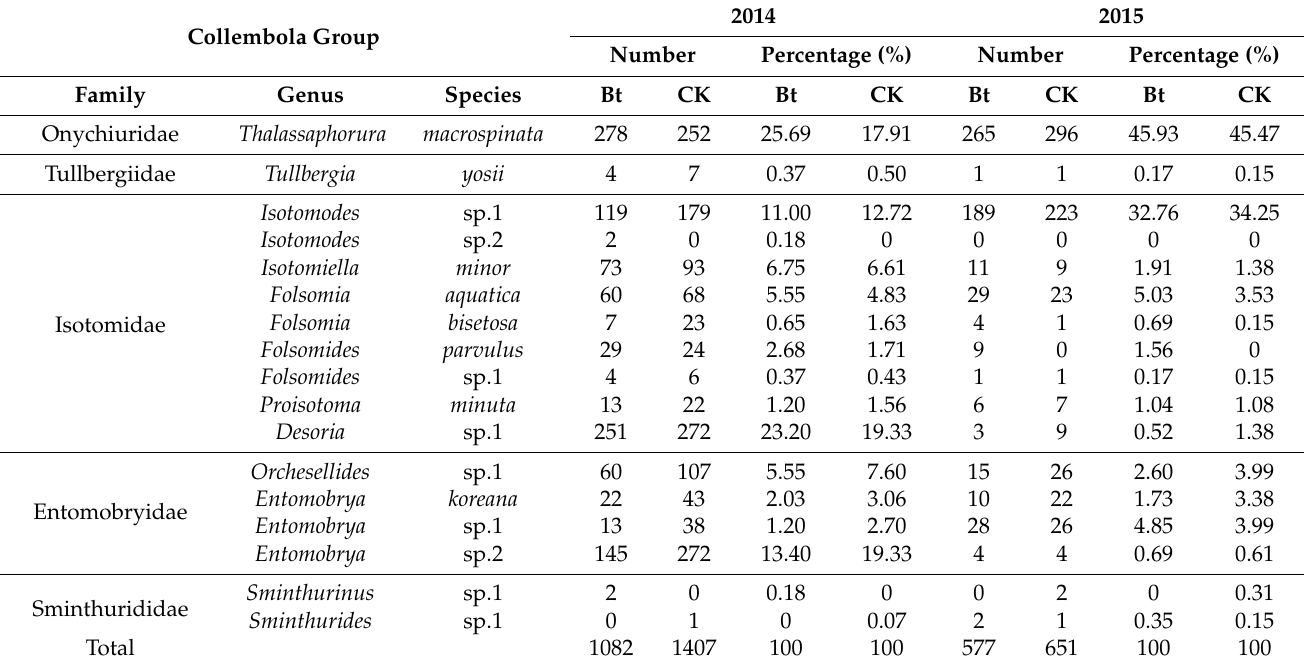
Table 2. Collembolan community composition in Bt maize IE09S034 and non-Bt maize Zong 31 in 2014 and 2015. Collembola Group